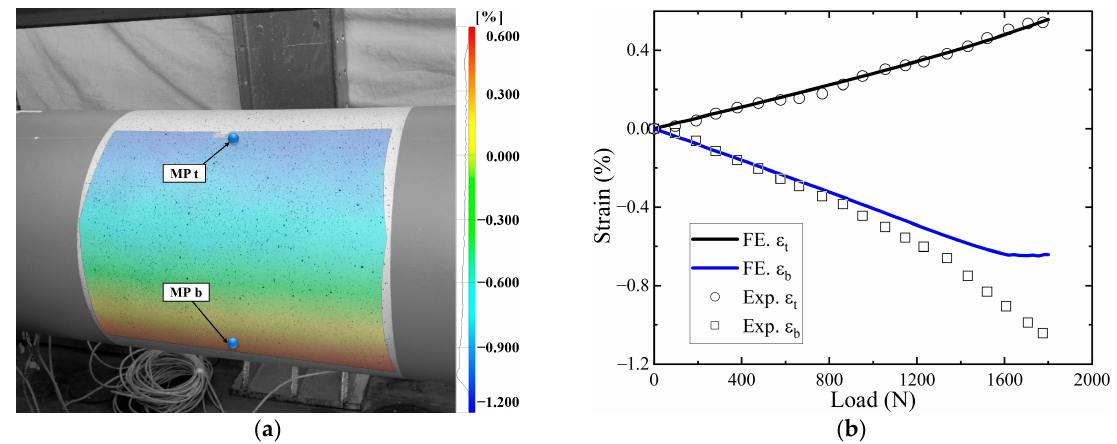
Figure 17. The axial strain–loading response of the midspan region: ( a ) the strain nephogram from the DIC; ( b ) the loading–strain curves.